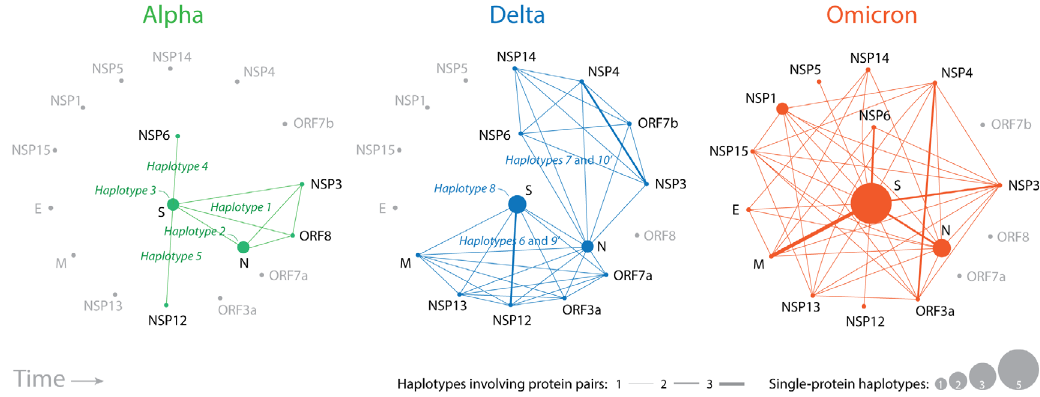
Figure 7. Evolving network diagrams describing SARS-CoV-2 protein interactions mediated by haplotypes. Nodes are proteins and lines in the graph are protein interactions manifesting as joint protein presence in a haplotype. Node size is proportional to the number of haplotypes harboring markers that affect only one protein. Line width is proportional to the number of haplotypes sharing the same pair of proteins. Larger nodes and thicker lines highlight the significance of protein